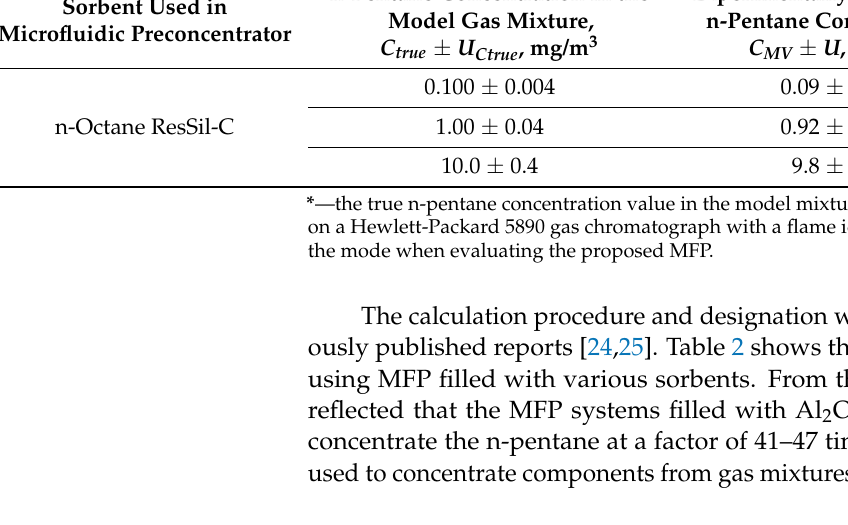
Table 2. Comparative evaluation between two methods used for analysis of n-pentane in air.